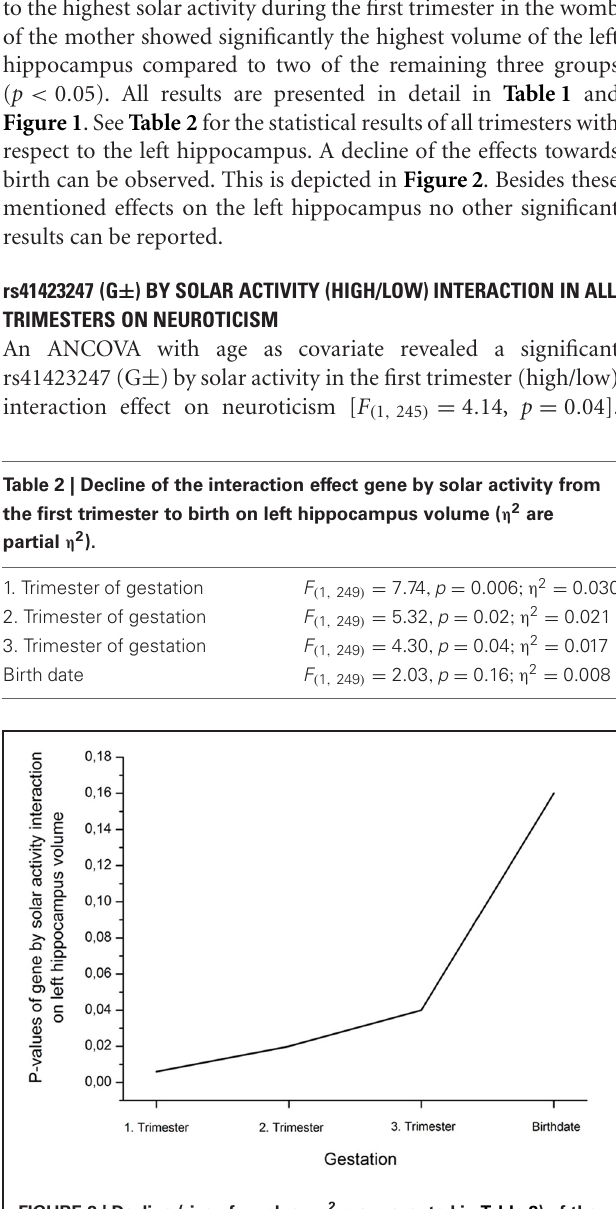
FIGURE 1 | Interaction effect of rs41423247 (G ± ) by solar activity in the first trimester (high/low) on the left hippocampus volume (means and SEM are presented; ∗ p < 0 . 05).